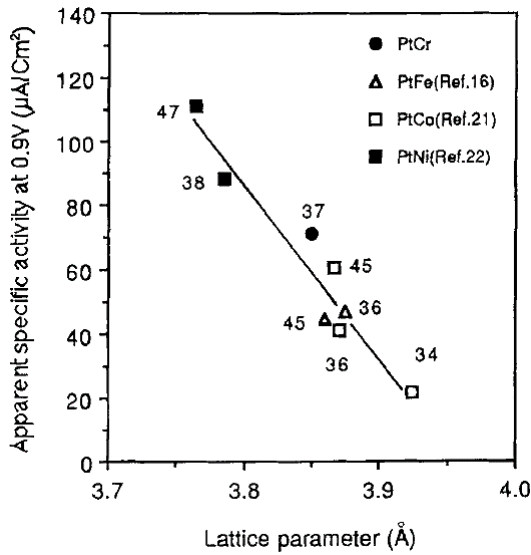
Figure 1. Apparent specific activity vs. lattice parameter for various alloy catalysts (Taken from [112] with permission. Referenced data points correspond to citation list from [112]; Copyright the Electrochemical Society, 1995).